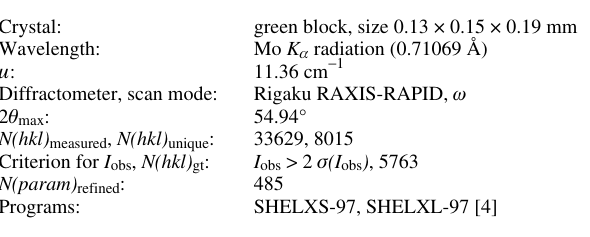
Table 1. Data collection and handling.